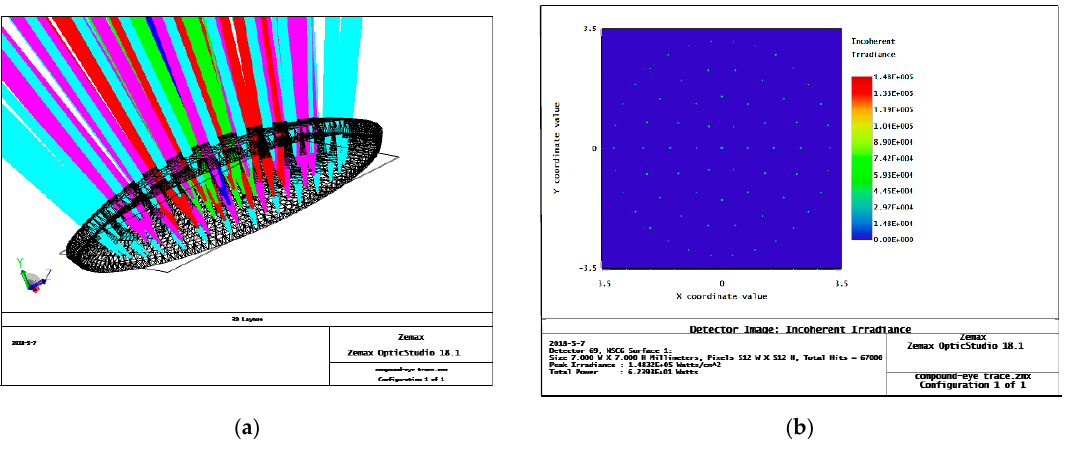
Figure 5. Ray tracing for the aspherical zoom surface compound eye model after optimization: ( a ) curved compound eye ray tracing, and different levels of sub-eyes use different colors of light to track; ( b ) the detector energy spot distribution; the energy speckle of each sub-eyes is relatively concentrated, and the peak irradiance is only 1.4832 × 10 5 Watts/cm 2 .